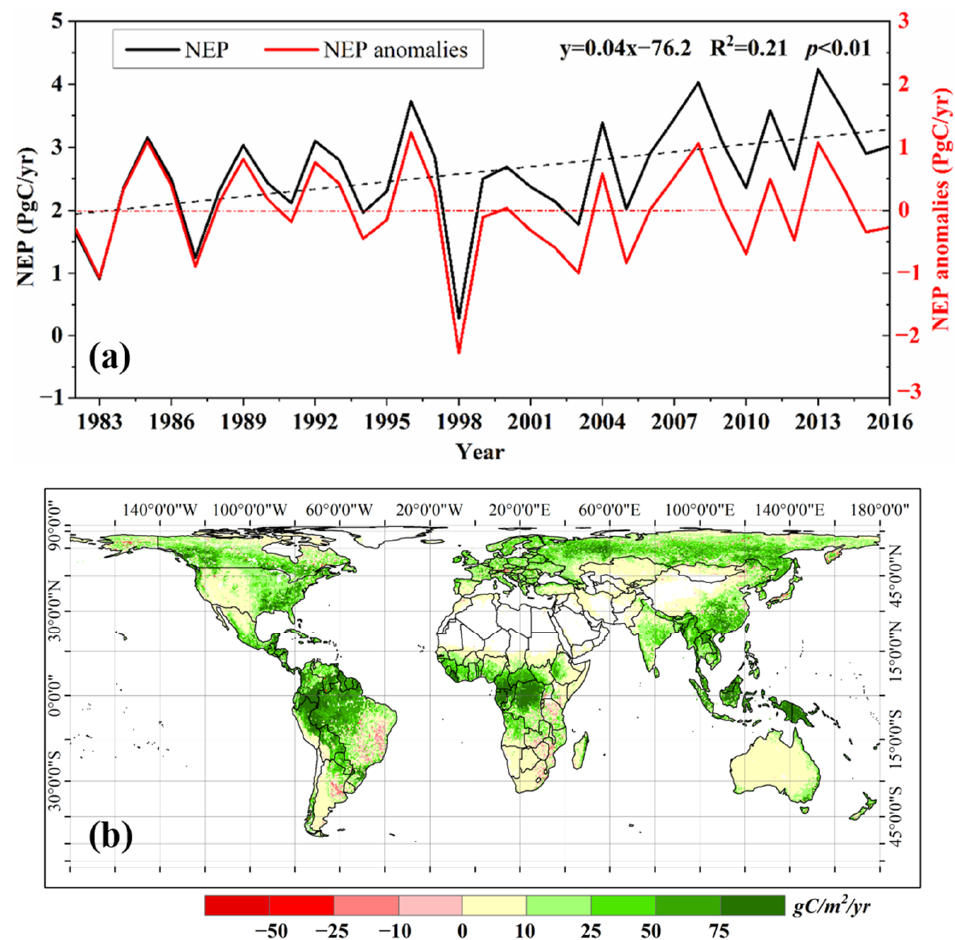
Figure 3. ( a ) Time series of NEP and NEP detrended anomalies, ( b ) the spatial distribution of annual mean NEP during 1982–2016.